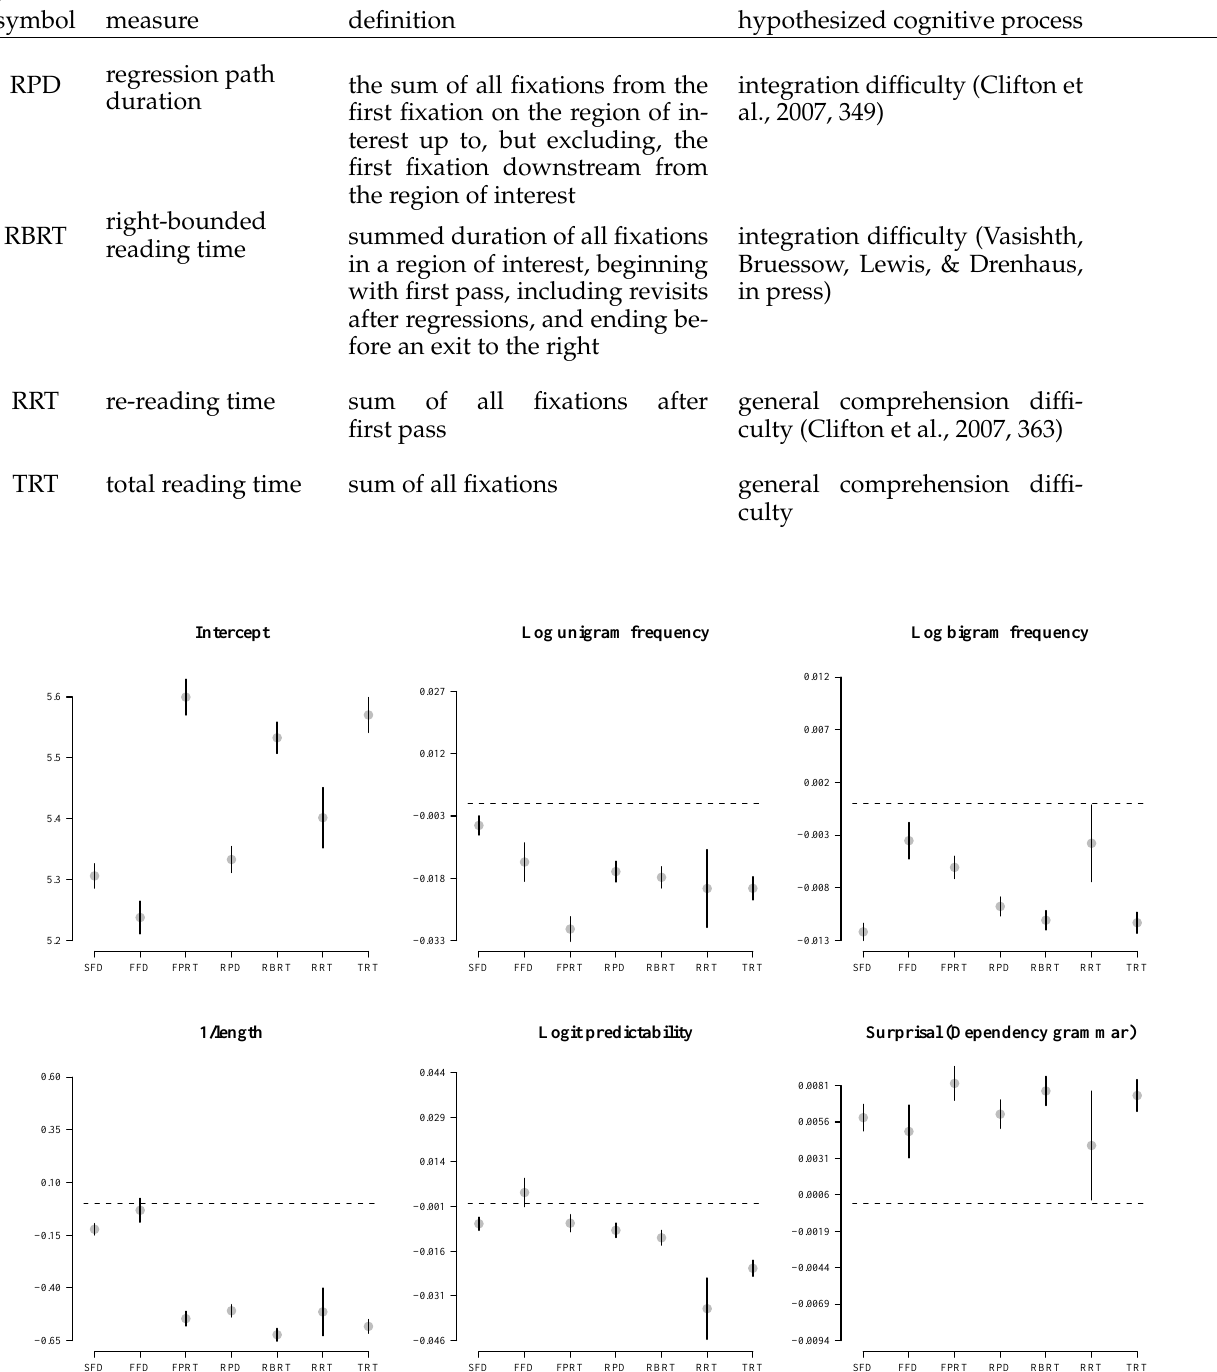
Commonly used non-first-pass dependent measures of eye movement and the stages in parsing processes they are assumed to represent.